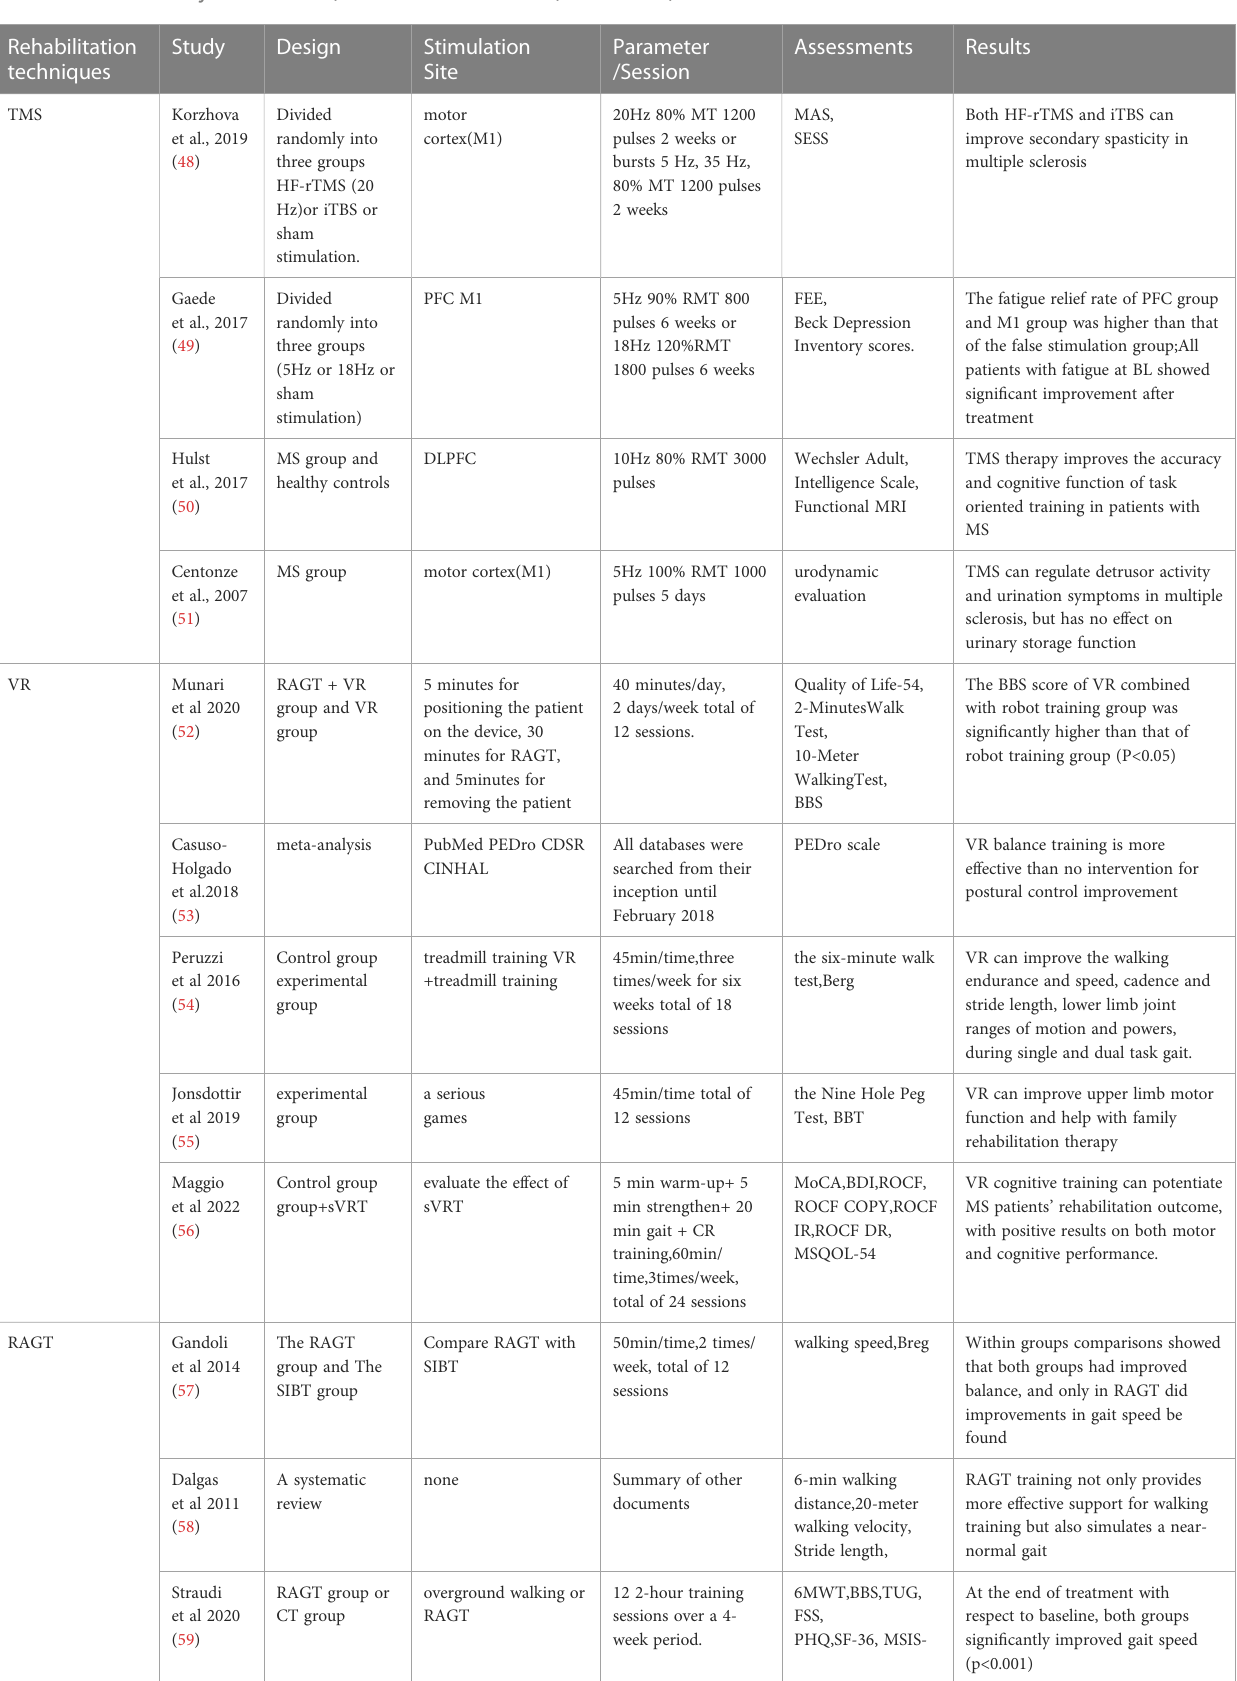
TABLE 2 Individual Study Characteristics, Treatment Characteristics, Assessments, and